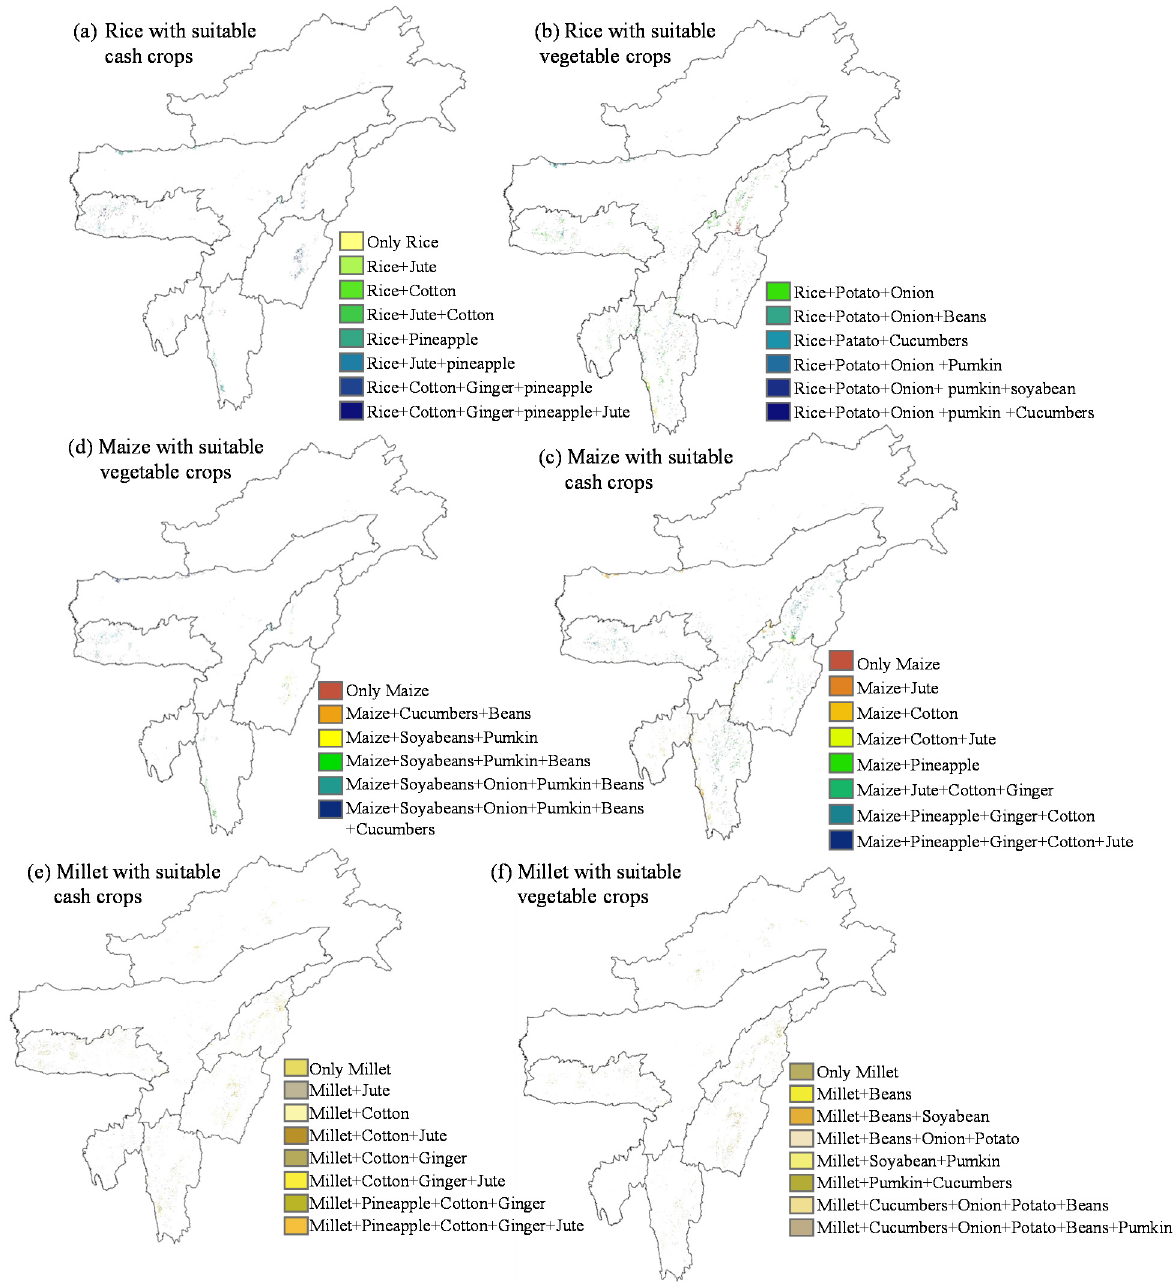
Figure 8. Various crop-suitability maps ( a ) Rice with cash crops ( b ) Rice with vegetable crops ( c ) Maize with cash crops ( d ) Maize with vegetable crops ( e ) Millet with cash crops ( f ) Millet with vegetable crops for shifting cultivation areas in NE India.